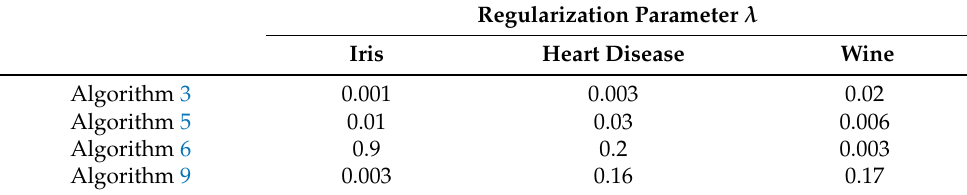
Table 3. Chosen λ for each algorithm.